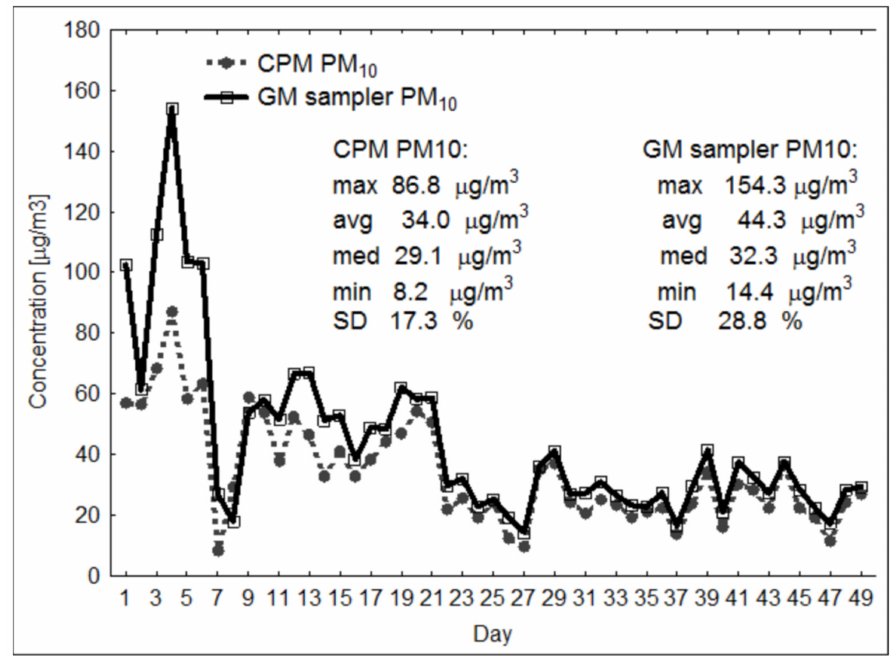
Figure 2. Average 24 h PM10 mass concentration obtained by two methods in winter campaign.